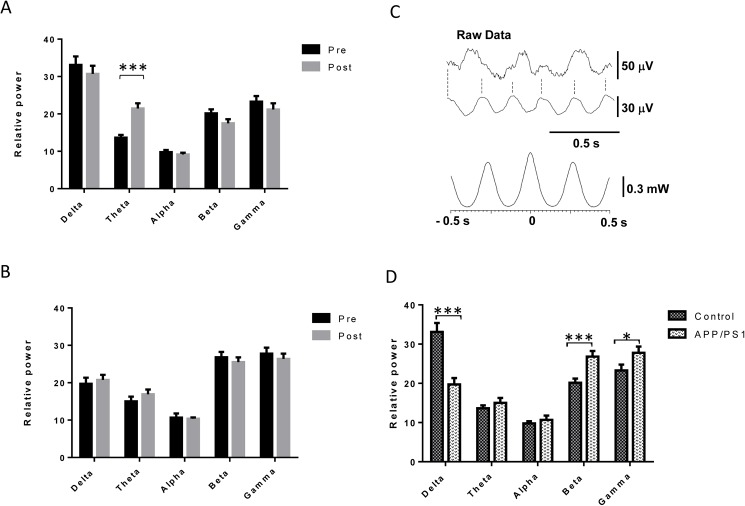
Differences in baseline and post-exercise electrocorticogram activity in APP/PS1 mice.A, A bout of moderate exercise specifically increases theta frequencies in the elecorticogram (ECG) of wild type mice (T = -5,72; df = 33; *p<0.05; n = 9). B, No changes are seen in APP/PS1 mice (n = 9) after exercise. Pre: 5 min ECG recordings before exercise; Post: 5 min ECG recordings after exercise. Results are the mean of pooling together ECG recordings performed by each mouse after 15 and 30 min of exercise in independent days. C, Electrophysiological simultaneous recordings of the ECG (upper record) and of the hippocampal CA1 region (lower record) when theta rhythm was evoked by sensory stimulation (Raw Data). Dashed vertical lines indicate the correspondence of positive peaks of hippocampal theta rhythm with positive peaks in the ECG. Lower plot shows the CC of the hippocampal theta rhythm respect to ECG activity after digital filtering between 4–8 Hz. Periodic peaks implies phase-locking of both theta rhythms. D, Baseline ECG recordings in wild type and APP/PS1 mice show differences in various frequency bands (Delta: t = 4,8; df = 68,56; Beta: t = -3,76; df = 72; Gamma: t = -2,04; df = 72; *p<0.05; ***p<0.001; n = 9 per group). Results shown are mean ± S.E.M.